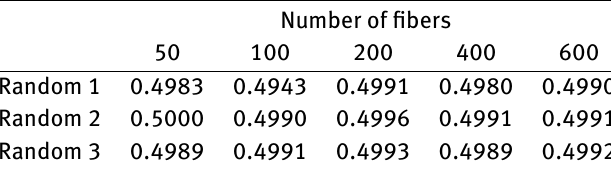
Table 1: Influence of random distributions of fibers on the effective thermal conductivity of composites with v f = 14%